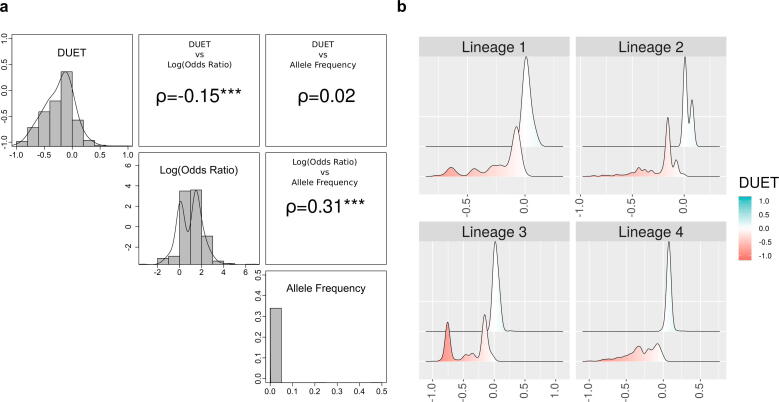
Relationship between the impact of katG mutations on Protein stability (DUET) with Odds Ratio (OR), Allele Frequency (AF) and Mtb lineages. a) Pairwise correlations between DUET protein stability and GWAS measures of OR and AF of 566 mutations (total number of mutations with associated OR). The upper panel in both plots include the pairwise Spearman correlation values (denoted by ρ) along with their statistical significance (***P < 0.001). b) Lineage distribution of samples with katG mutations showing Mtb lineages 1–4 according to DUET protein stability ranging from red (-1, most destabilising) to blue (+1, most stabilising). The number of samples within each lineage are: Lineage 1 (n = 2448), Lineage 2 (n = 6813), Lineage 3 (n = 5020) and Lineage 4 (n = 2739). The number of samples contribute to the 566 katG mutations. Figure generated using R statistical software, version 3.6.1. (For interpretation of the references to colour in this figure legend, the reader is referred to the web version of this article.)